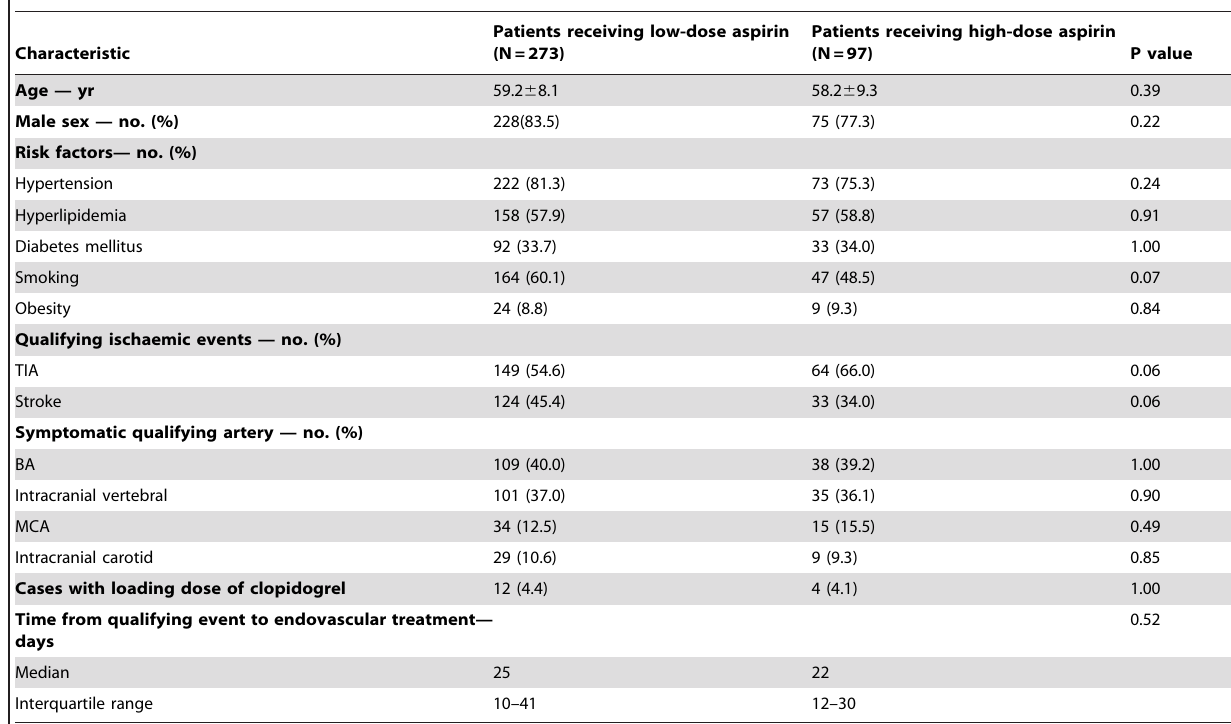
Table 1. Comparison of baseline characteristics of patients receiving low-dose aspirin and patients receiving high- dose aspirin * .